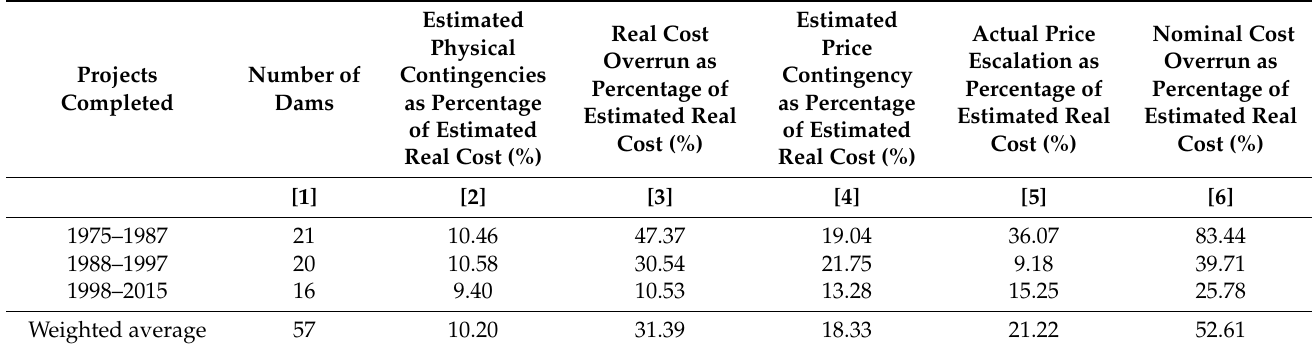
Table 6. Comparison of cost overruns for different